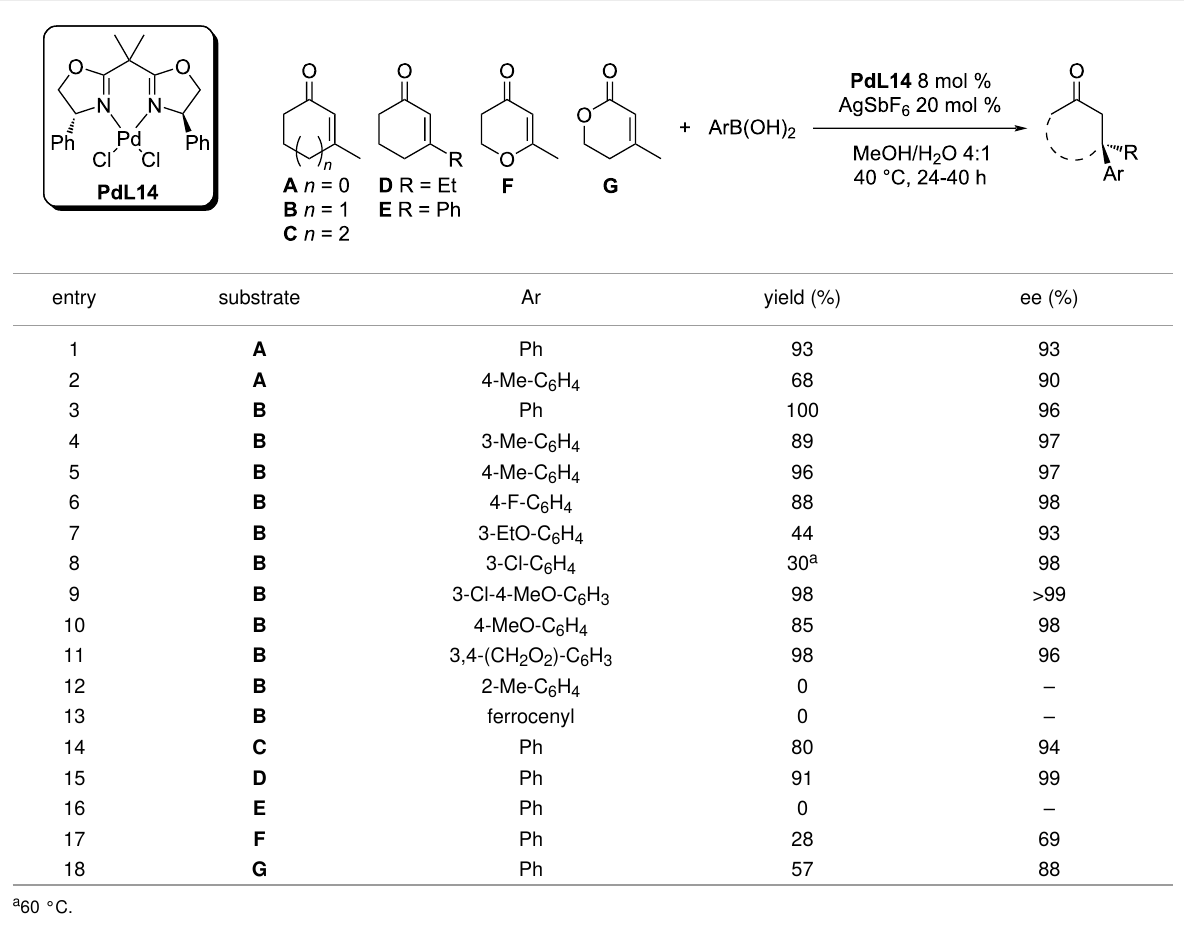
Table 33: Addition reactions of arylboronic acids to various enones catalysed by palladium bisoxazoline complex PdL14 [14].